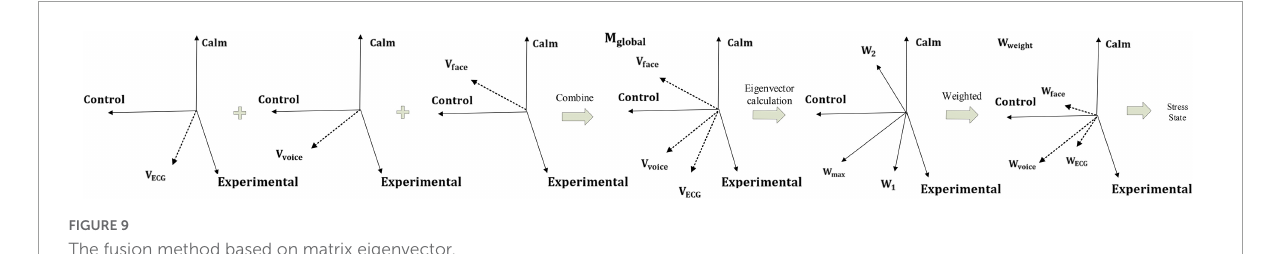
FIGURE9 The fusion method based on matrix eigenvector.